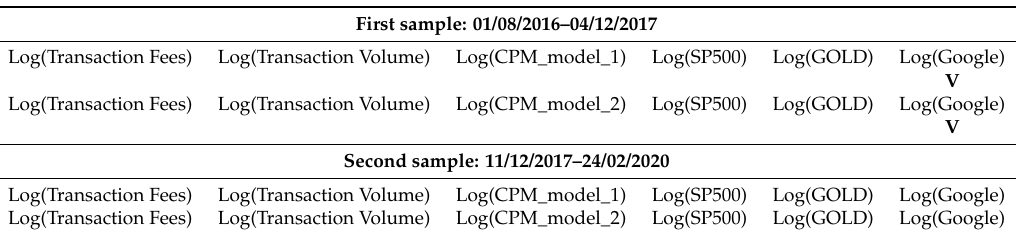
Table A11. Weak exogeneity tests: variables for which the null hypothesis of weak exogeneity can be rejected after re-testing at the 5% probability